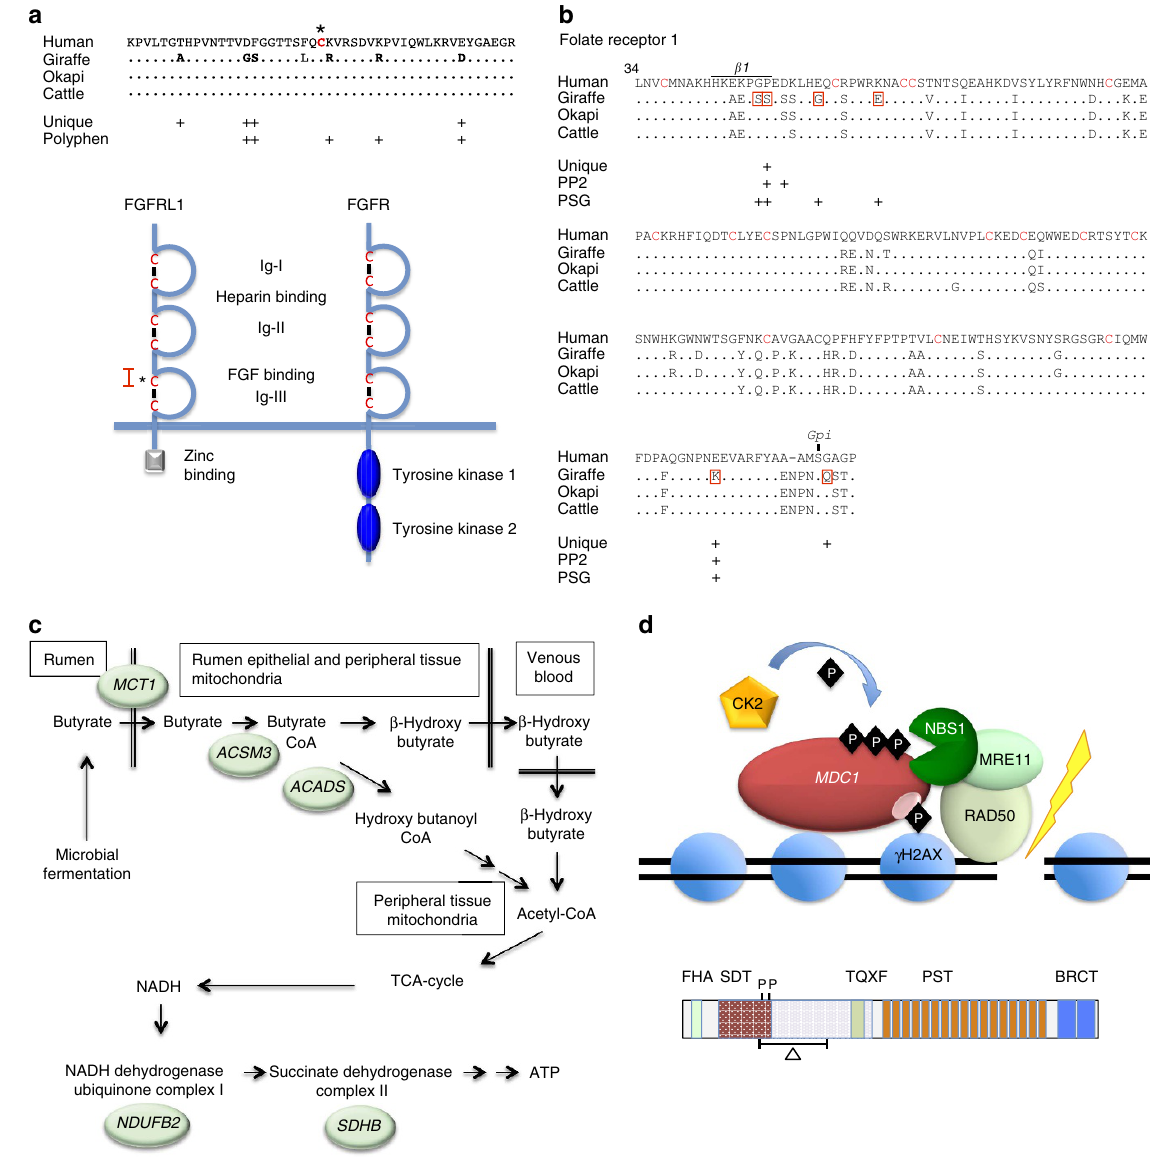
Figure 3 | Giraffe genes and pathways exhibiting extraordinary divergence and patterns of amino acid substitutions. ( a ) Giraffe FGFRL1 contains seven amino acid substitutions that are unique at fixed sites in other mammals and/or are predicted by Polphen2 analysis to alter function (upper panel). Human reference is shown, which is identical to cattle and okapi in this segment. The unique giraffe substitutions occur in the FGF-binding domain region flanking the N-terminal cysteine (asterisk) of the Ig-III loop (lower panel). Red bracket in lower panel corresponds to the sequence in the upper panel. The extracellular structure of FGFRL1 (left) is the same as a prototypical FGF receptor (FGFR, right) but lacks the cytoplasmic C-terminal tyrosine kinase domains seen in FGFR and instead contains a zinc-binding domain. ( b ) Giraffe FOLR1 contains seven substitutions that each show evidence of positive selection ( P o 0.05) by the branch-site model. Two of the positive selected sites (PSG), P48S and E222K, are also unique substitutions at fixed sites and Polyphen2 (PP2) analysis predicts them to alter function. P48S is within b -sheet-1 that forms part of the folic acid-binding pocket. The FOLR1 protein forms a globular structure maintained by overlapping disulfide bridges between 16 cysteine residues (red) and tethered to the plasma membrane at S233 by a Gpi anchor. The unique substitution in giraffe, G234Q, immediately adjacent to the Gpi anchor site may alter the anchor site or the rate of its formation. ( c ) Genes encoding key enzymes in butyrate metabolism and downstream mitochondrial oxidative phosphorylation pathways have diverged in giraffe including the monocarboxylate transporter ( MCT1 ), acyl-coenzyme A synthetase-3 ( ACSM3 ), short-chain specific acyl-CoA dehydrogenase ( ACADS ),